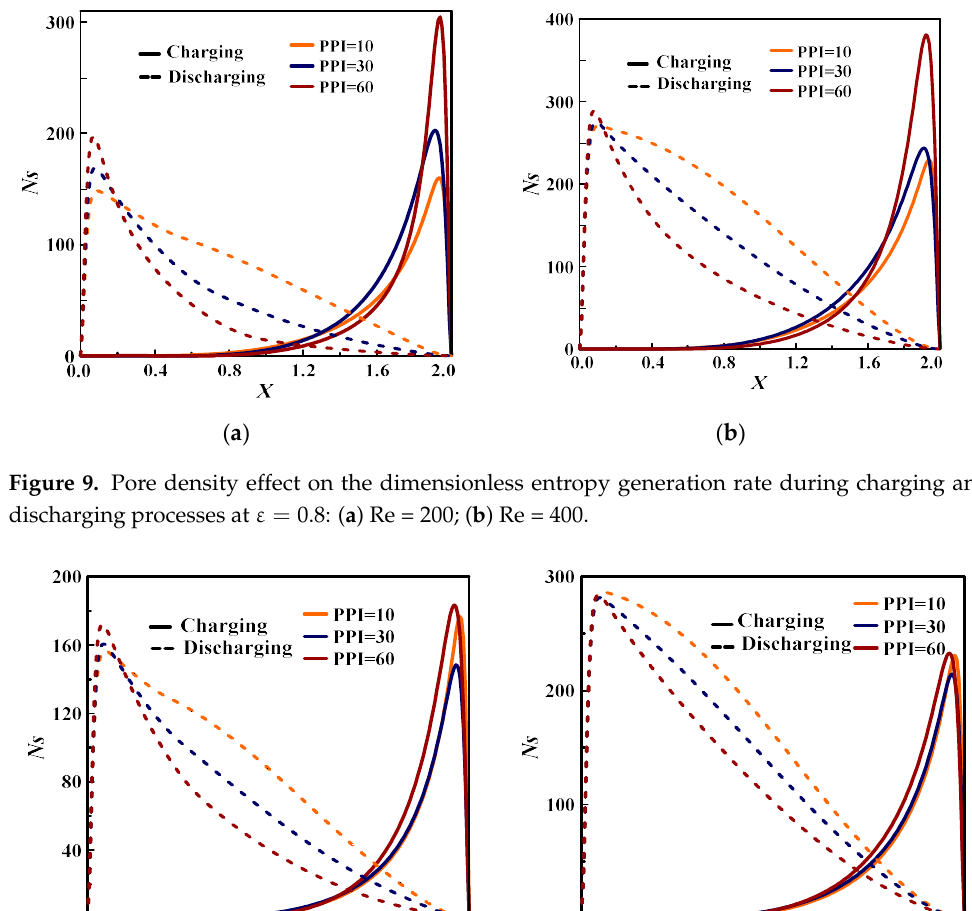
Figure 8. Pore density effect on the dimensionless entropy generation rate during charging and discharging processes at ε = 0.7: ( a ) Re = 200; ( b ) Re = 400.